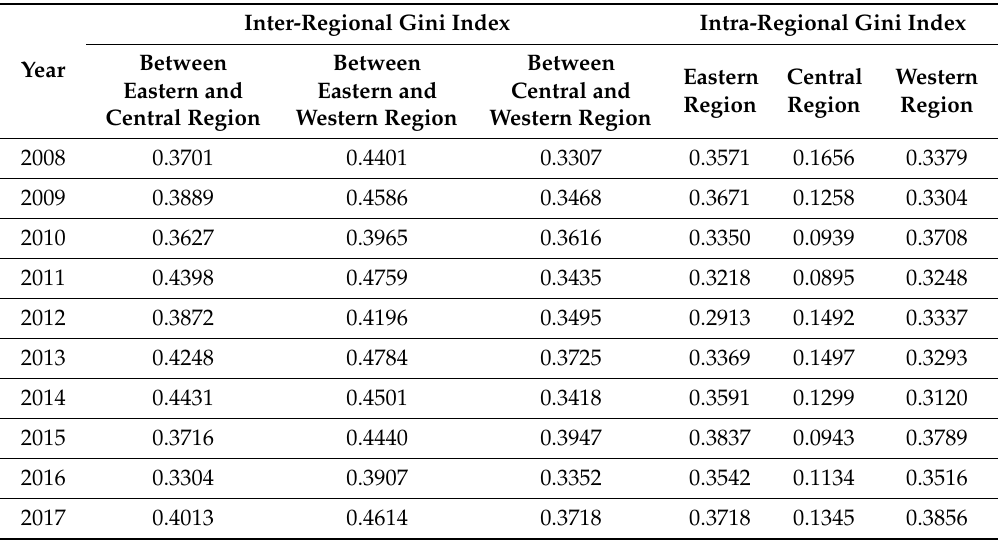
Table 3. Gini index decomposition of regional di ff erences in allocation e ffi ciency of rural public health resources in China from 2008 to